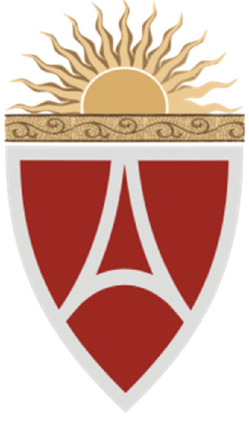
Figure 12. Arms with heraldic sun: Aerodrom.